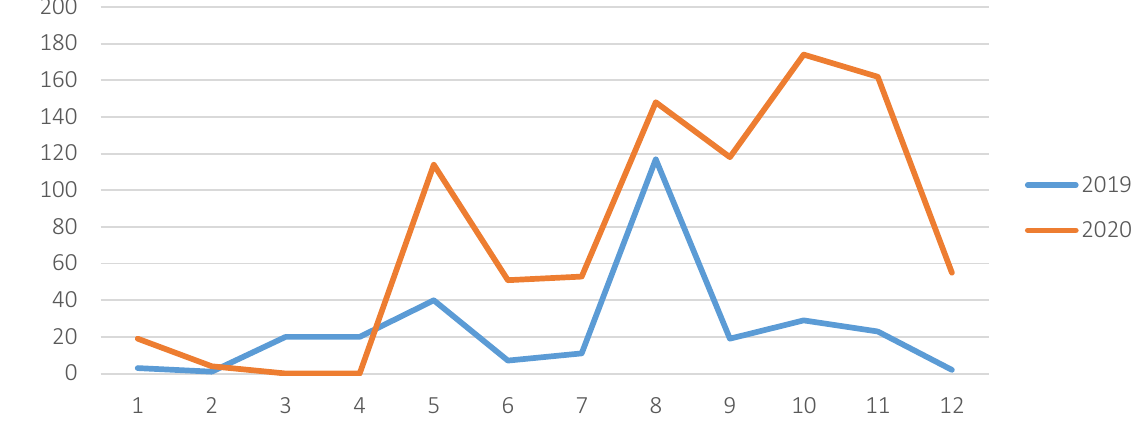
Figure 8. Monthly distribution of the number of Ukrainian participants in brokerage events in 2019